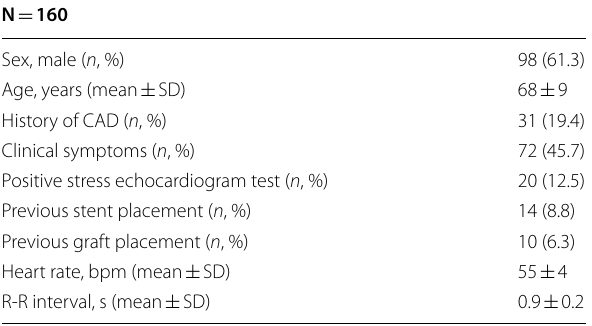
Table 2 Clinical data of enrolled patients